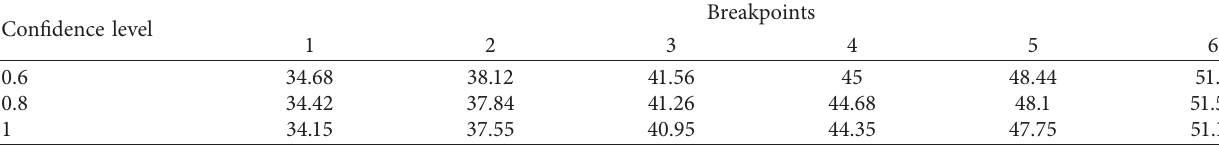
Table 7: Breakpoint values for the second sample problem.